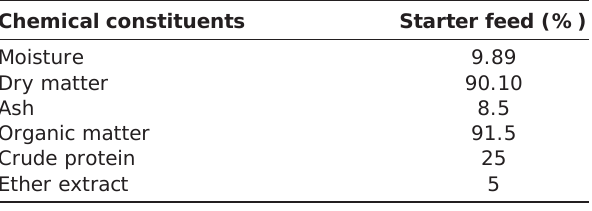
Table-1: Chemical composition of broiler starter